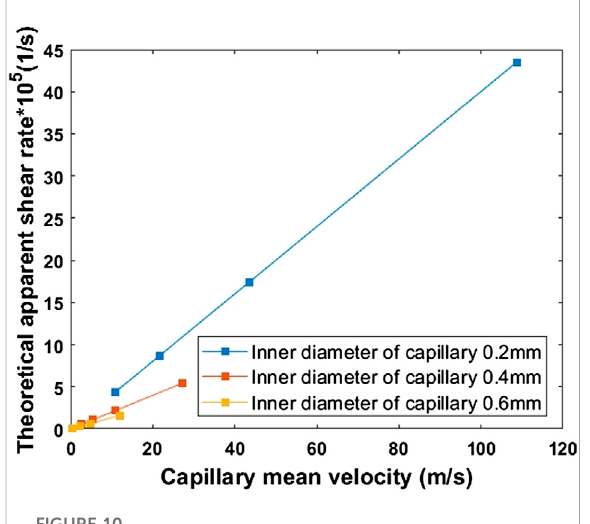
FIGURE 11 Apparent viscosity as a function of shear rate. FIGURE 10